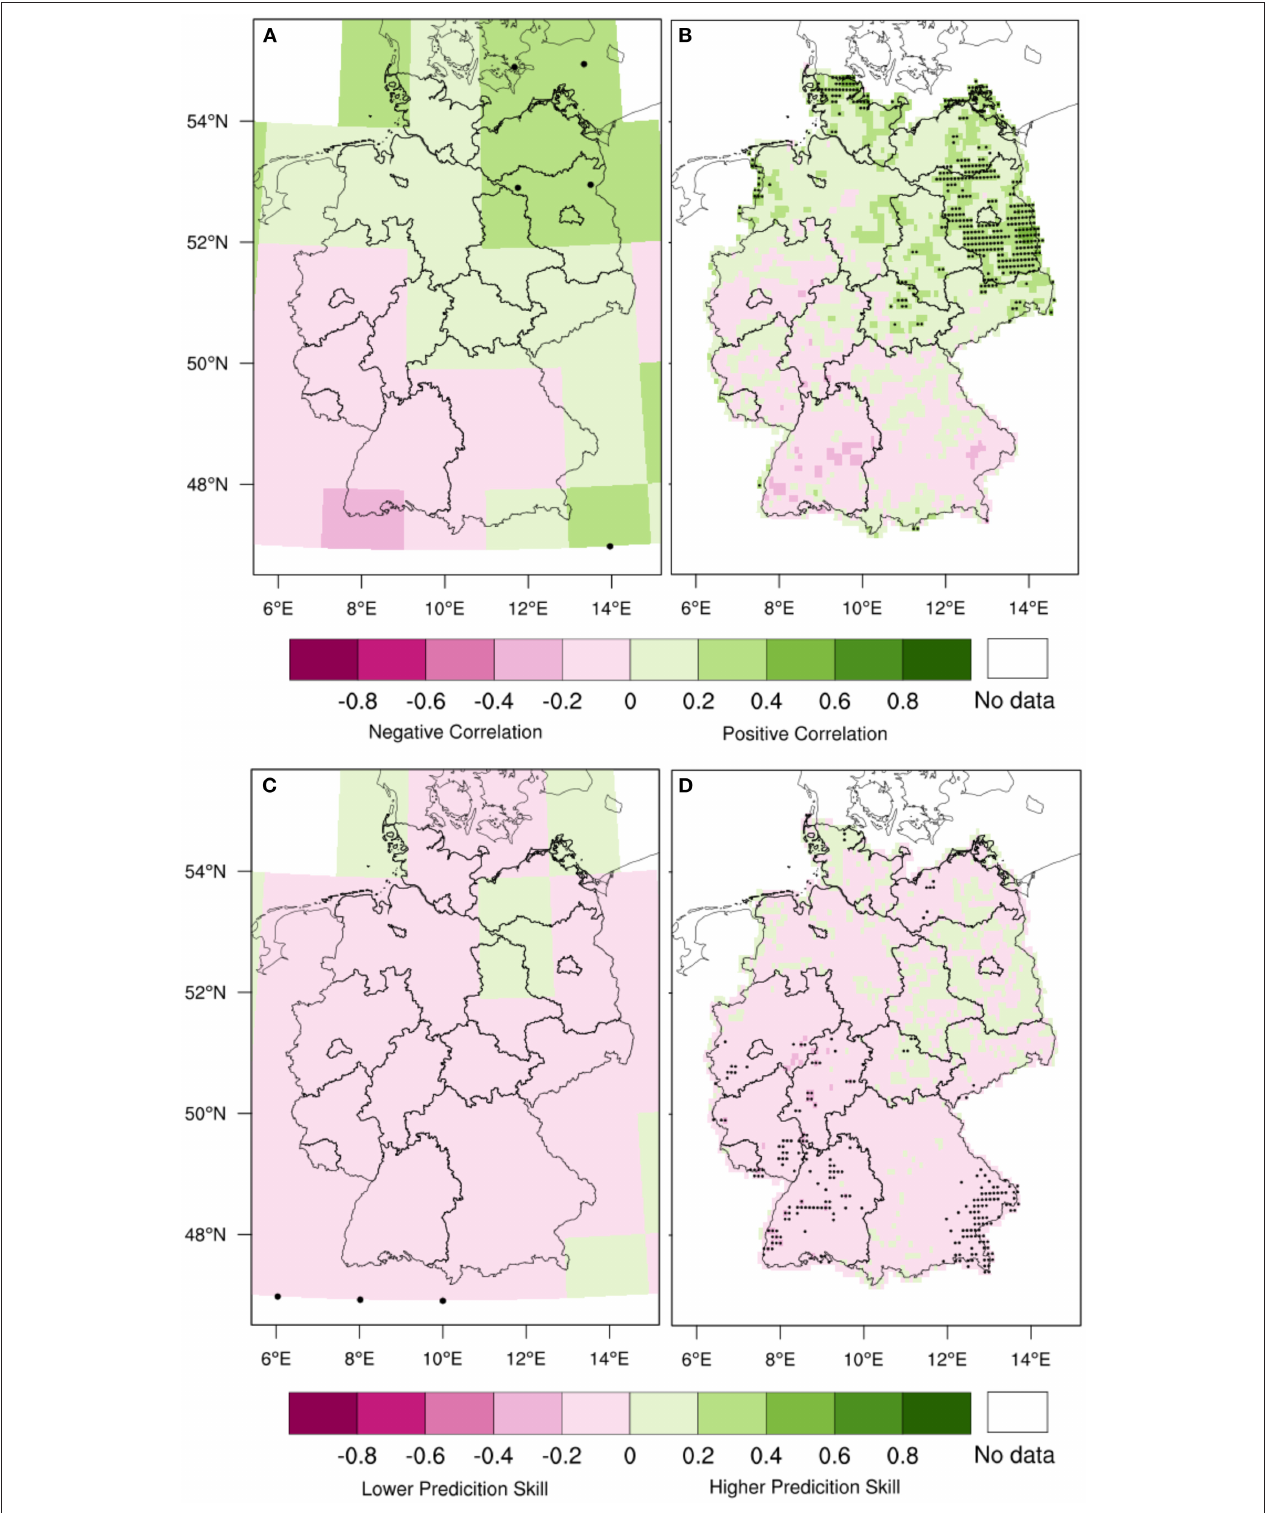
FIGURE 2 | Decadal prediction skill for 3-year means of annual precipitation for forecast years 1–3 in the evaluation period 1961–2020: (Anomaly) correlation coefficient between MPI-ESM-LR at ∼ 200km (A) or EPISODES at ∼ 11km (B) and HYRAS observations and RPSS of MPI-ESM-LR (C) or EPISODES (D) compared to the observed HYRAS climatology as reference prediction. Dots indicate significant skill (significance level of 95%).